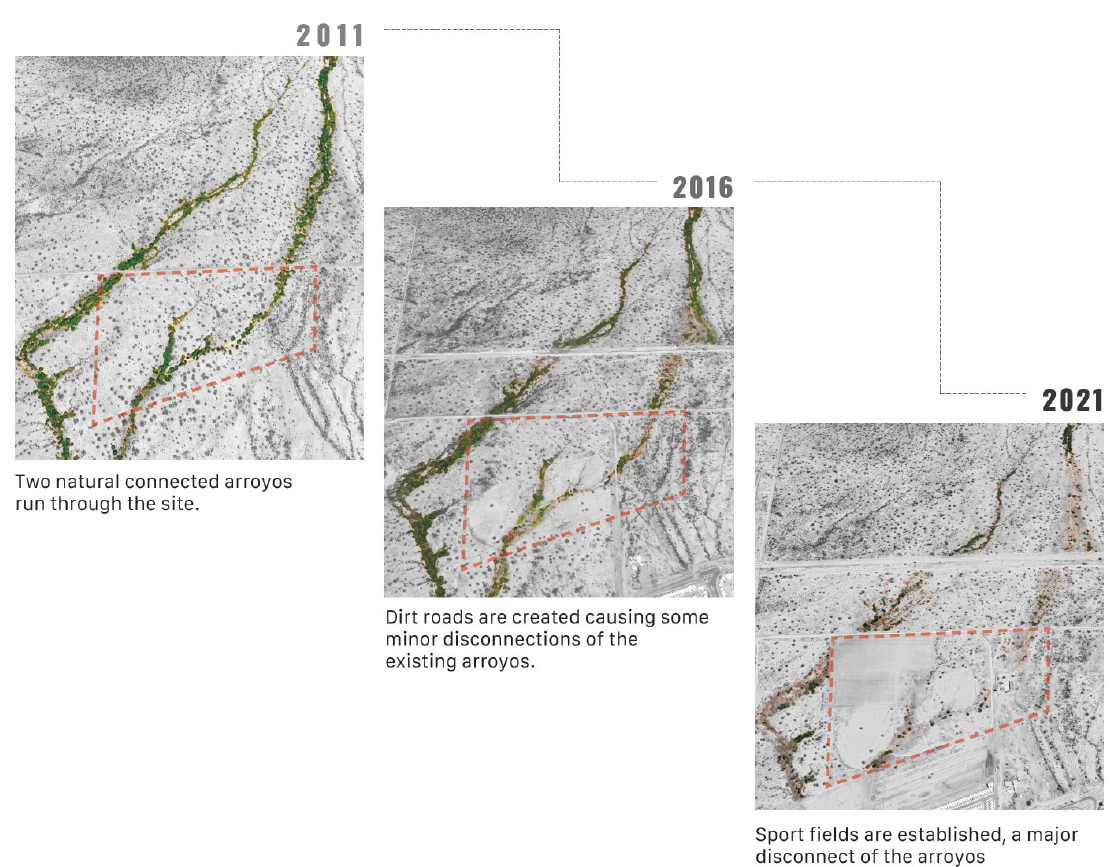
Figure 10. Site disturbance through time, seen from aerial photos (credit: I. Pineda). During the site visit, the team also found that the inhabitants use this open area not only for soccer practice, but also to dump their trash, including electronic waste. At several points there was evidence that suggested the incineration of garbage as a common practice, harming the local flora, increasing the risk of wildfire, and polluting the air and runoff (Figure 12). This way, the natural soils in the donated zone were not only compacted, but also